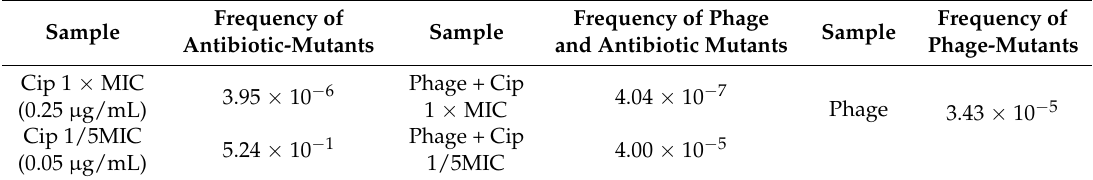
Table 2. Frequency of transformed E. coli spontaneous phage-resistant